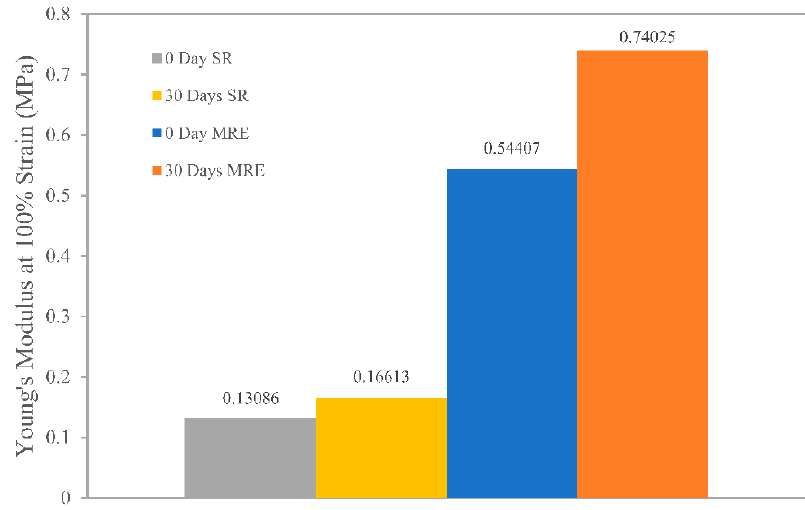
Figure 5. Young’s modulus of SR and MRE under natural weathering conditions.